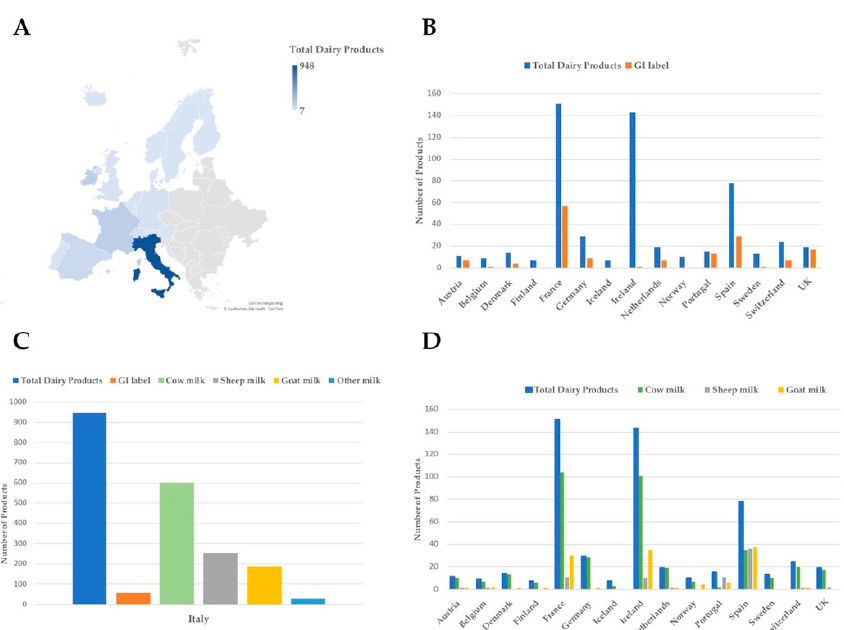
Figure 2. Distribution of dairy products within Western European countries: Panel ( A ) map of Western Europe showing the distribution of traditional dairy products for each country. The number of products is represented by a color gradient, spanning from 7 (Finland and Iceland) to 948 (Italy); Panel ( B ) number of total (blue) and GI labelled (orange) dairy products for each country; Panel ( C ) number of total dairy products (blue), GI labelled (orange), and number of those derived from cow (green), sheep (grey), goat (yellow) or other milk sources, for Italy; and Panel ( D ) number of total dairy products (blue), and number of those derived from cow (green), sheep (grey) or goat (yellow) milk, for each country.